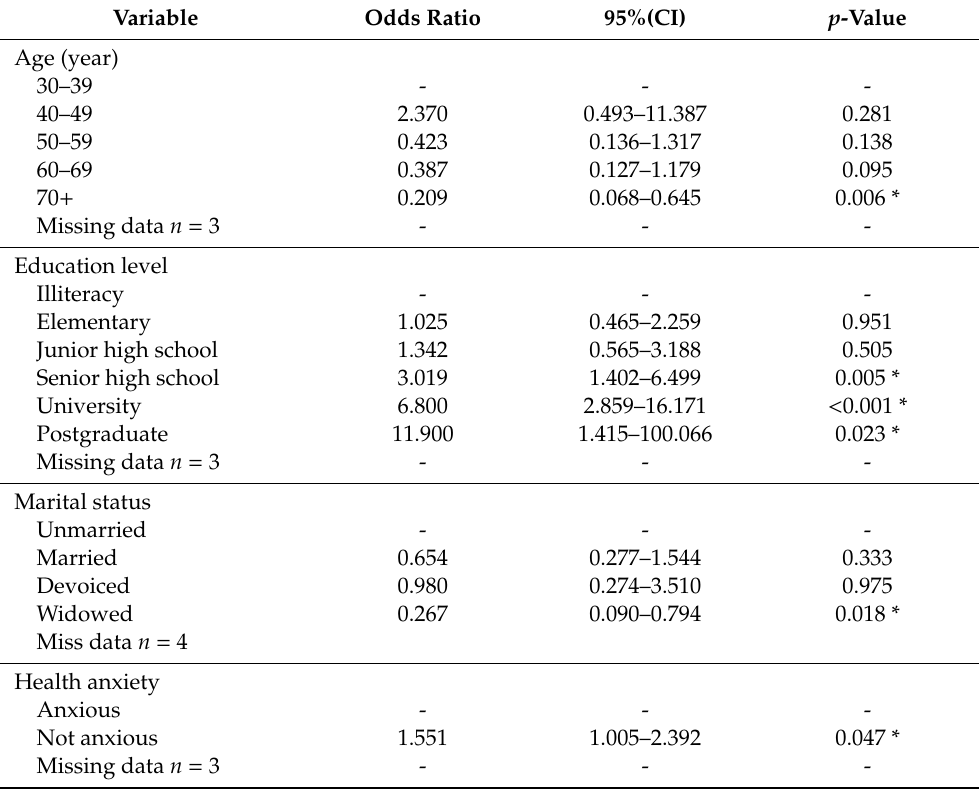
Table 3. Influence of socio-demographic characteristics on willingness to participate in health